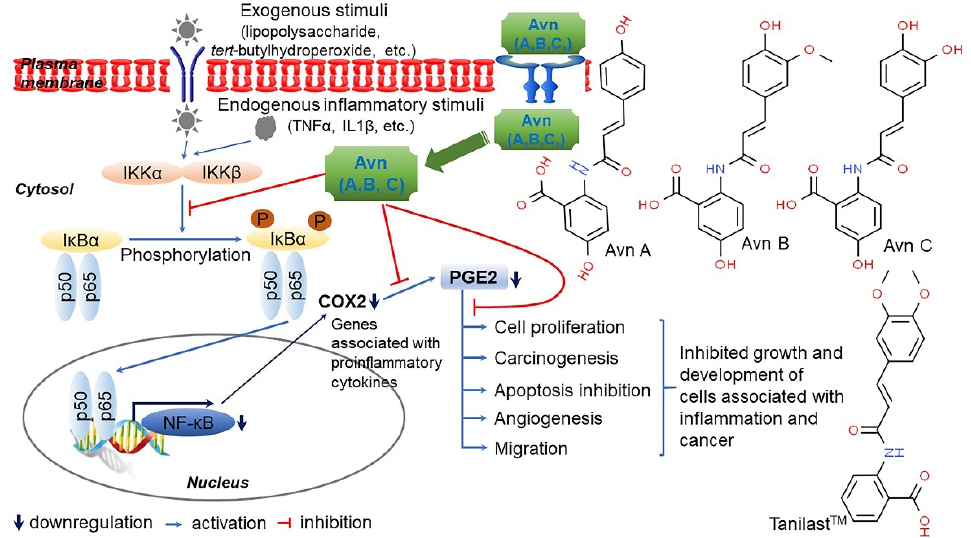
Figure 8. A predicted mechanism of avenanthramides (Avns)-mediated anti-inflammatory in skel- etal muscle C2C12 cells. Avns, the polyphenolic molecules identified solely in oats, exhibit anti- inflammatory activity mainly by inducing nuclear factor-kappaB (NF- κ B) inactivation in C2C12 cells. Avns downregulated the expression of I κ B kinase beta (IKK β ) as an inhibitor of NF- κ B kinase subunit beta in cellular response to tert -butyl hydroperoxide (tBHP)-meditated oxidative stress and attenuated the expression tumor necrosis factor alpha (TNF α ) and interleukin 1 β (IL-1 β ) at the tran- scriptional level under the same condition. Furthermore, Avns reduced the expression of cyclooxy- genase-2 (COX-2) protein, along with decreased prostaglandin E2 (PGE2) levels. The downregu- lated COX2/PGE2 pathway leads to the inhibition of cell proliferation, migration, apoptosis sup- pression, angiogenesis, and carcinogenesis in various cell lines. Thus, Avns can be potent inhibitors of NF- κ B-mediated inflammatory response following the downregulation of IKK β activity in C2C12 cells [109,110].